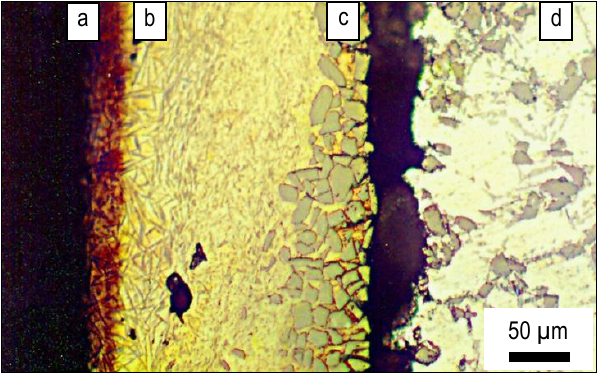
Figure 9: Microstructure of A359/SiC after drilling with YAG laser (a) laser cut area, (b) Al 4 C 3 rich area, (c) SiC rich area, and (d) parent A359 aluminum MMC. Notice the crack dividing zones (c) and (d). The needle-like Al 4 C 3 precipitates are still visible in zones (a) and (b) after ground, polished, and washed in water during sample